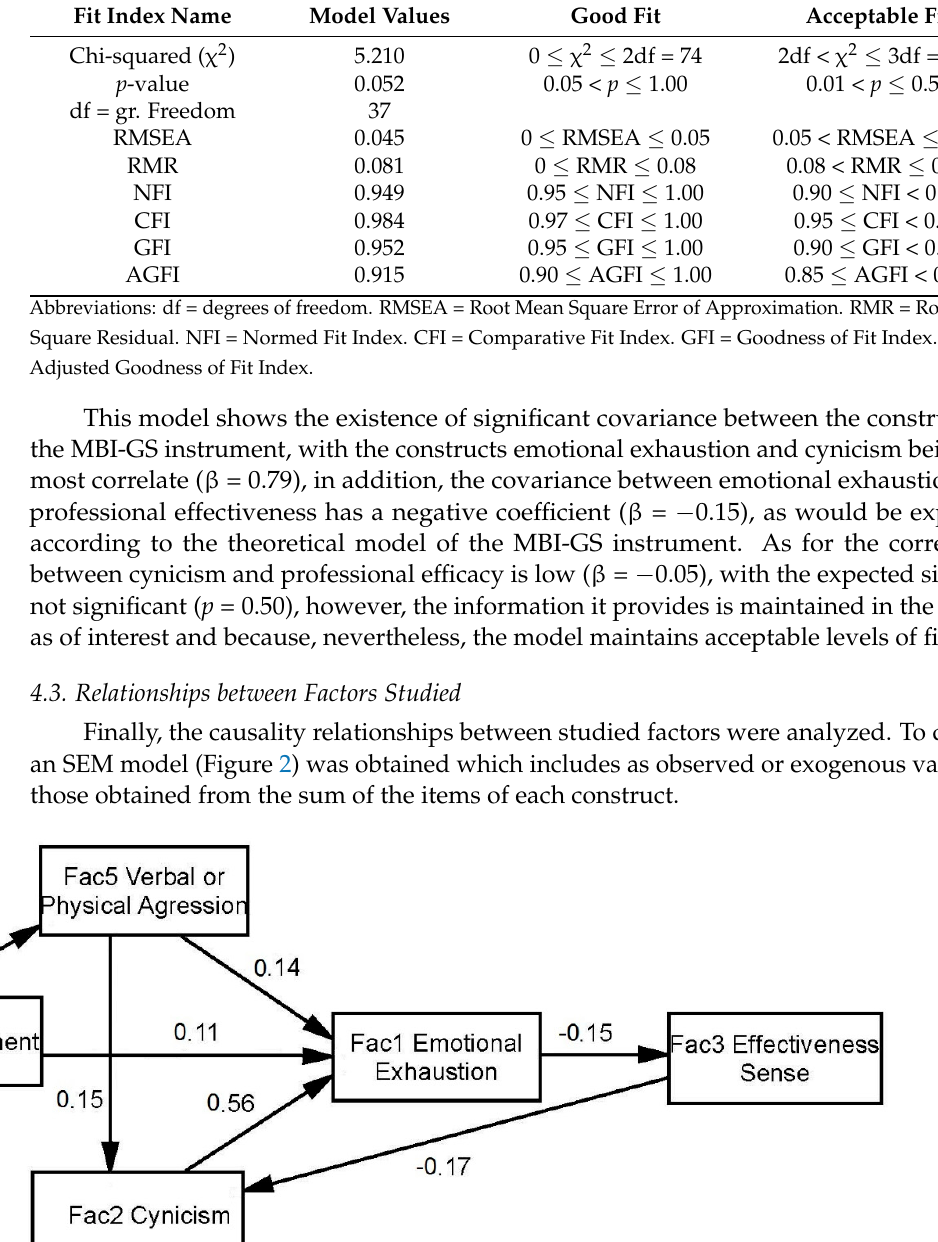
Table 8. Model adjustment rates associated with the MBI-GS questionnaire.